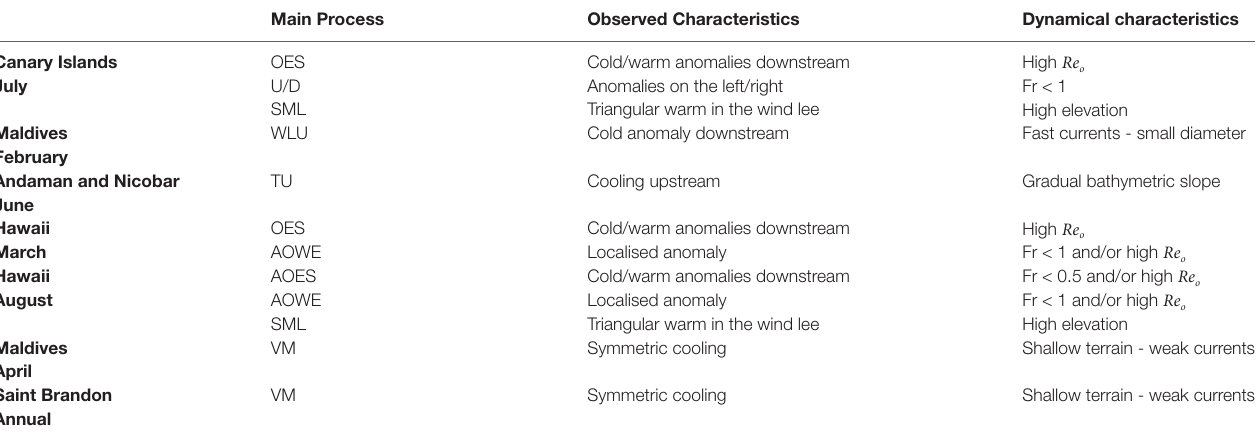
TABLE 1 | List of the islands considered in the analysis, prevailing processes and surface imprint